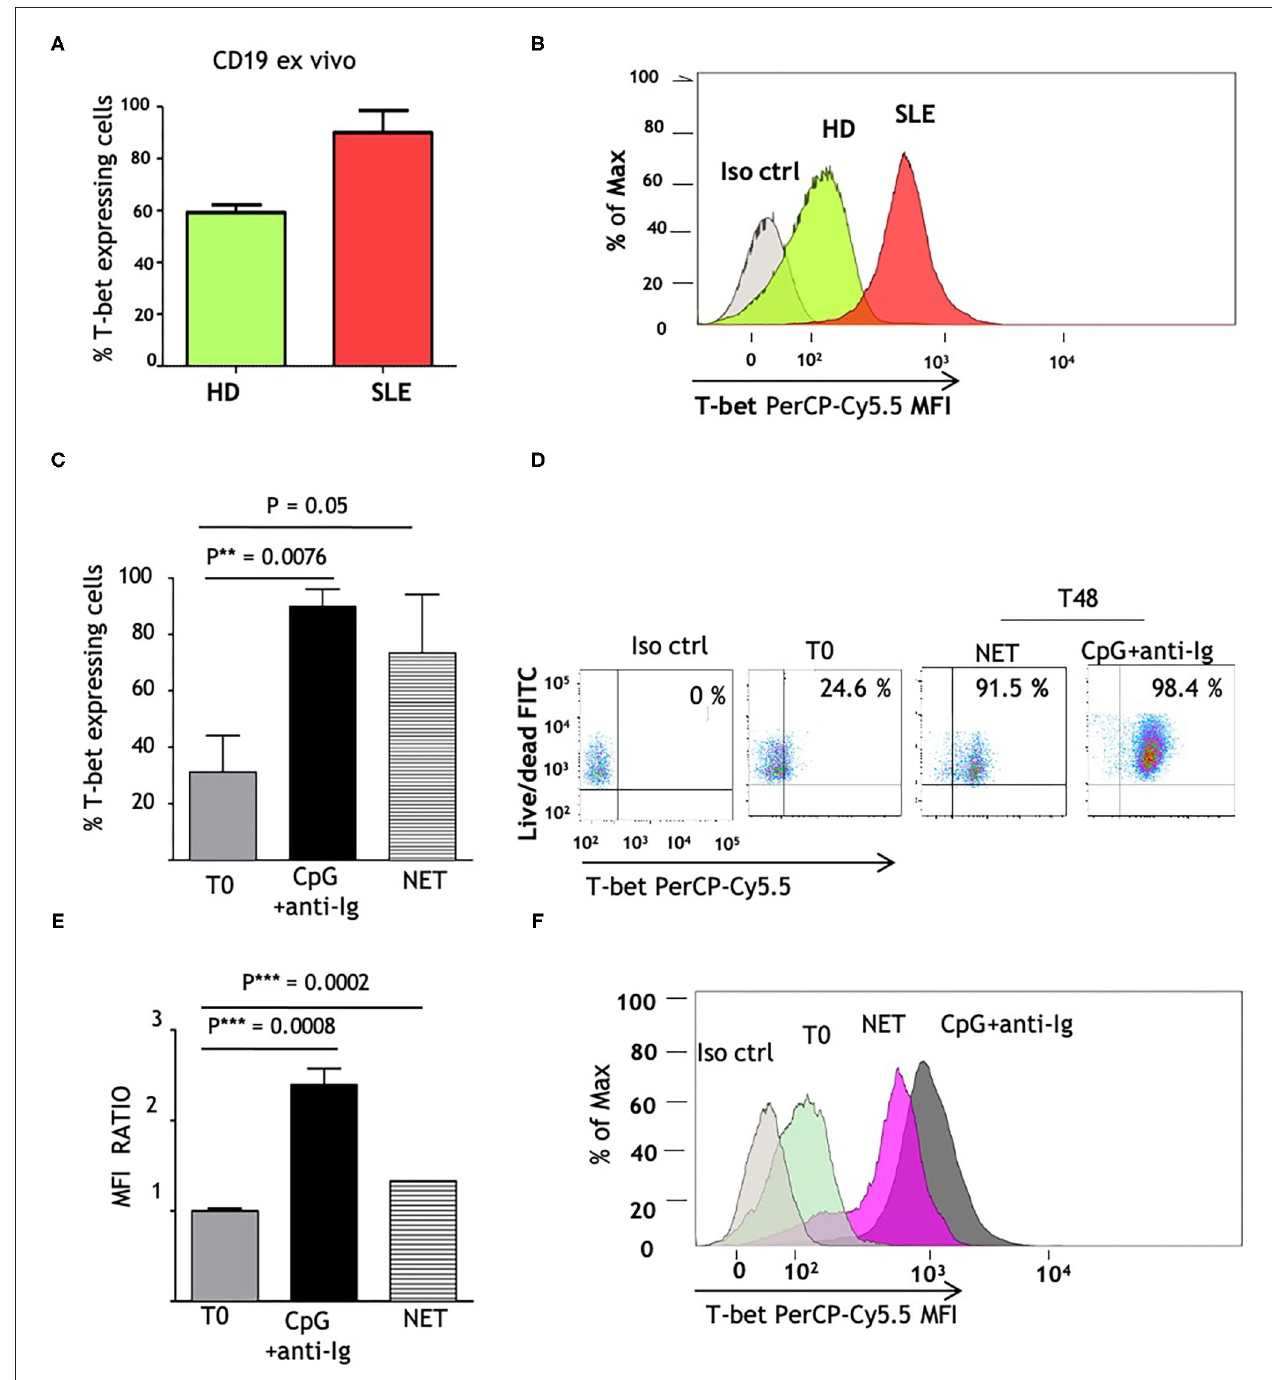
FIGURE 3 | NET induces T-bet expression in human naïve B cells. (A) Comparison of ex vivo T-bet expression in B lymphocytes, isolated from normal (HD) vs. SLE patients. CD19 + cells were purified from frozen PBMCs samples, as described in section Materials and Methods. Intracellular PerCp Cy5.5 fluorescence (T-bet expression) was assessed by flow cytometry. Values indicate the percentages of PerCp Cy5.5 positive (T-bet expressing) cells, determined in a in gated viable (FITC dim ) cell population, and represent the mean of three independent experiments. (B) Representative overlay histogram depicting PerCp-Cy5.5 Geometric MFI in T-bet expressing cells, detected in one normal control and in one patient with SLE. (C) Percentages of T-bet expression in freshly isolated naïve B cells, obtained from healthy donors as described in Materials and Methods, before (T0) and after 48h stimulation (T48) with CpG + anti-Ig (solid bar), or with LN-NET (dashed bar). NET extracts were added at the concentration of 0,5 µ g/ml protein T-bet expressing cells percentages were determined by flow cytometry as described above. The values represent the mean of three independent